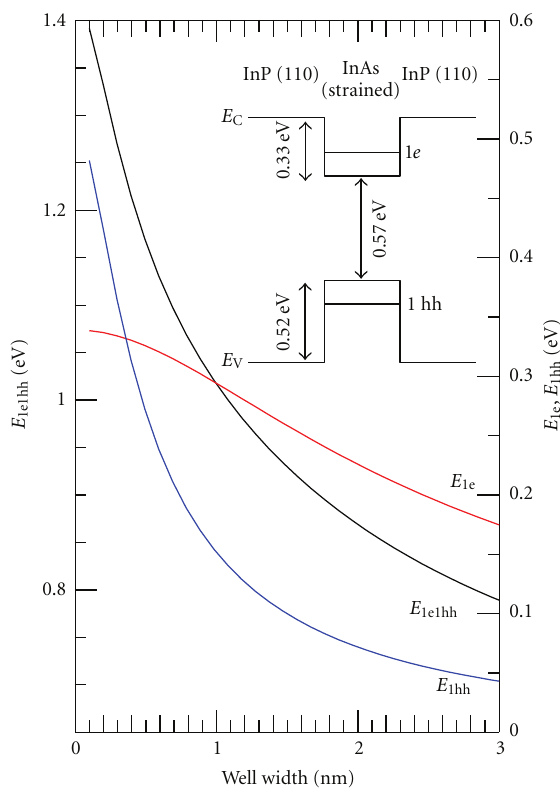
Figure 22: Plot of ground-state transition energy as function of well width for InP/InAs/InP strained QW on InP (110)